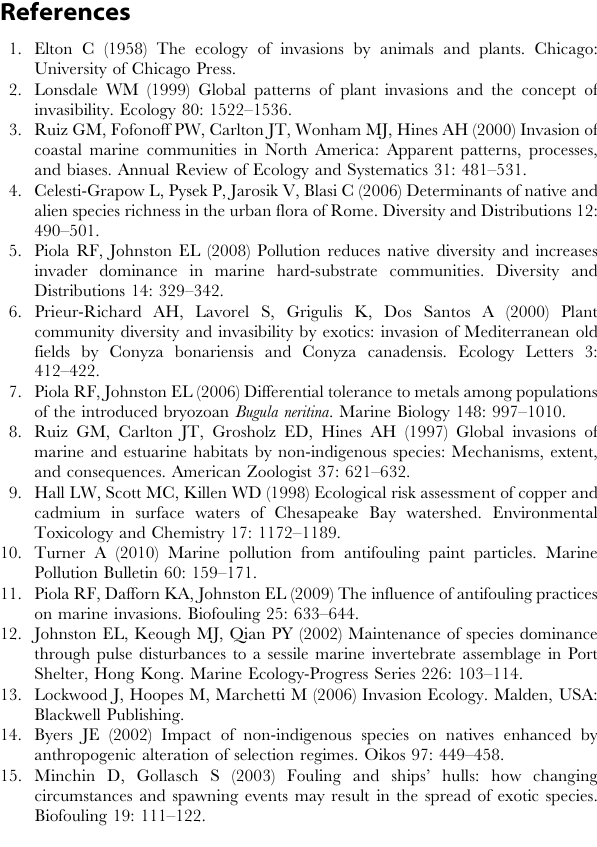
Figure S2 Individual replicates from fouling communi- ties in Panama across disturbance treatments. Panel A – D0; panel B – D1; panel C – D2 and panel D – D3. See Methods for details.